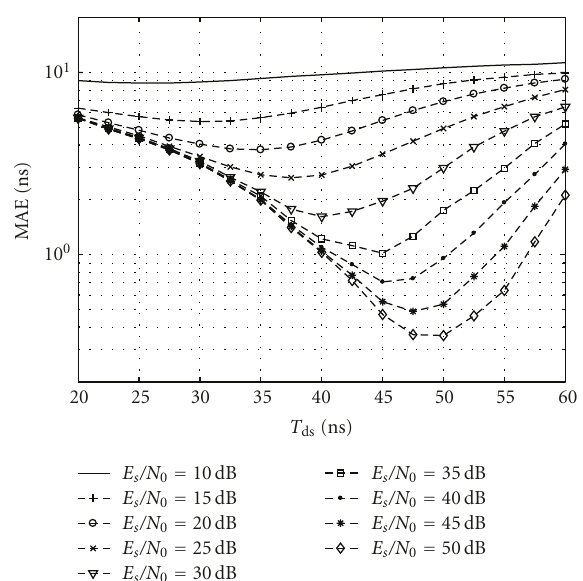
Figure 5: MAE versus channel delay spread setting for di ff erent SNR in CM1 with N s = 8, N f = 4, and f s = 8GHz.